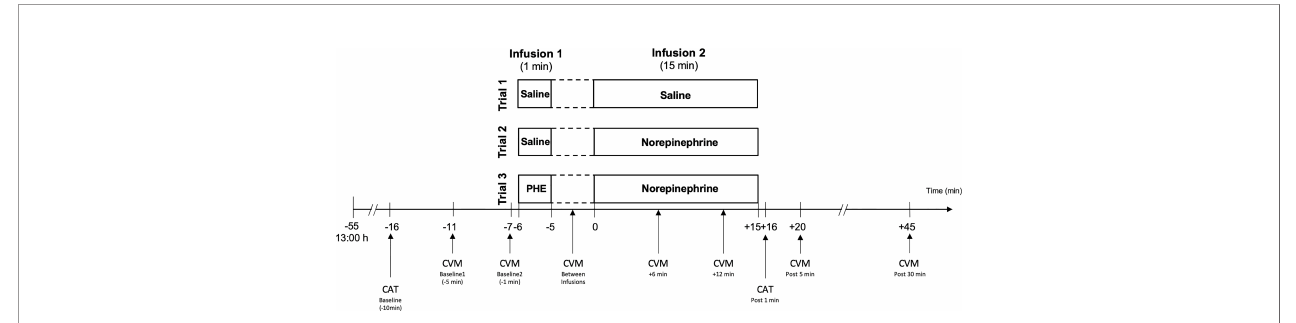
FIGURE 2 | Infusion procedure and measurements. Infusion dosages: Norepinephrine: 75 µ g (5 µ g/ml/min); PHE: 2.5 mg. CVM, cardiovascular measurement; i.e. blood pressure and heart rate assessment; CAT, catecholamine assessment; PHE, phentolamine; post, post infusion